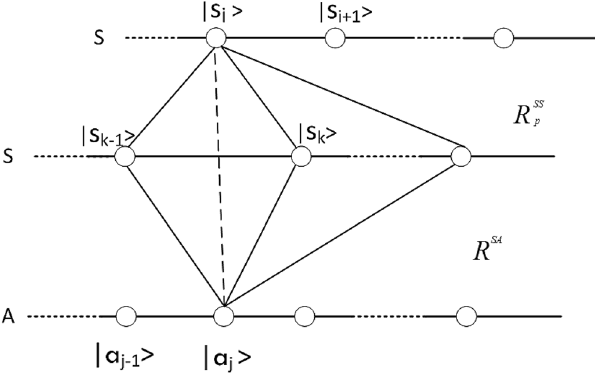
Figure 1. Summation of alternatives for probability